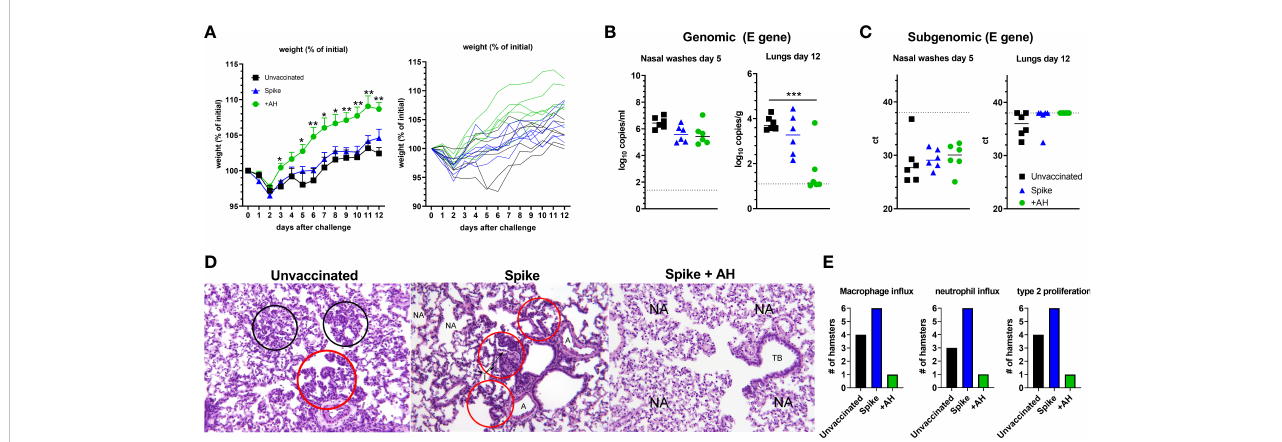
FIGURE 2 Spike protein adjuvanted with aluminium hydroxide (AH) protects against challenge with SARS-CoV-2. Syrian golden hamsters were immunized with two doses of spike trimer protein alone or formulated in AH and challenged intranasally with 1.8x10 5 TCID 50 of SARS-CoV-2. (A) Percent weight change. Individual hamsters are displayed in the right panel. (B) Viral load by qPCR in the nasal washes at 5 dpi (left panel) and in lungs at 12 dpi (right panel) measured by qPCR against the E-gene. (C) Subgenomic RNA in the nasal washes at 5 dpi (left panel) and in lungs at 14 dpi (right panel). Statistically signi fi cant differences are indicated by *** (one-way ANOVA using the unvaccinated group as reference, p<0.001). There was no statistically signi fi cant difference among groups if not otherwise indicated. (D) Right diaphragmatic lung lobe were fi xed in 10% formalin, cut and stained with Hematoxylin and Eosin (HE) to examine pulmonary pathology at 12 dpi. Representative stainings (obj. x 10) of unvaccinated animals (left panel) show in fl ux of in fl ammatory cells (black circles). Red circles show type II pneumocyte hyperplasia. Spike vaccinated animals (middle panel) had in fl ammatory cells present within alveoli (I) and type II pneumocyte hyperplasia (red circles). Few normal alveoli (NA) are present (A) normal arteria. Spike + AH vaccinated animals (right panel) had normal alveoli (NA) and normal terminal bronchiole (TB). (E) Number of hamsters in each group having in fl ux of the indicated in fl ammatory cells and type II pneumocyte proliferation, respectively (n =3 (mock) to 6 (vaccinated and/or challenged) hamsters per